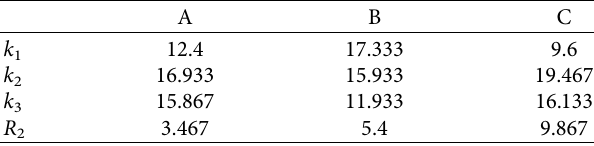
2 ) of paste filling.